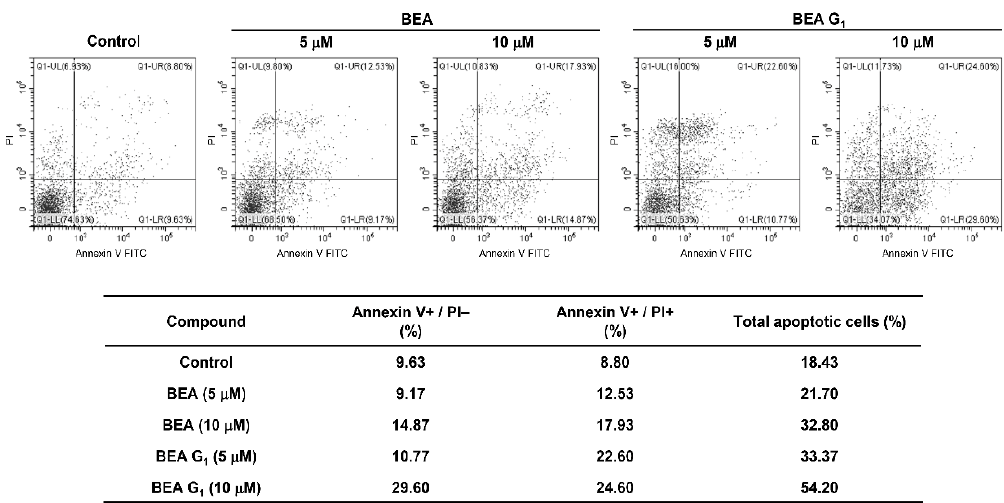
Figure 4. Effects of BEA and BEA G 1 on the apoptotic cell death of A375SM melanoma cells. The cells were treated with BEA and BEA G 1 (5 and 10 μM) for 24 h. Apoptotic cells were identified by flow cytometry following Annexin V-FITC and PI dual labeling.